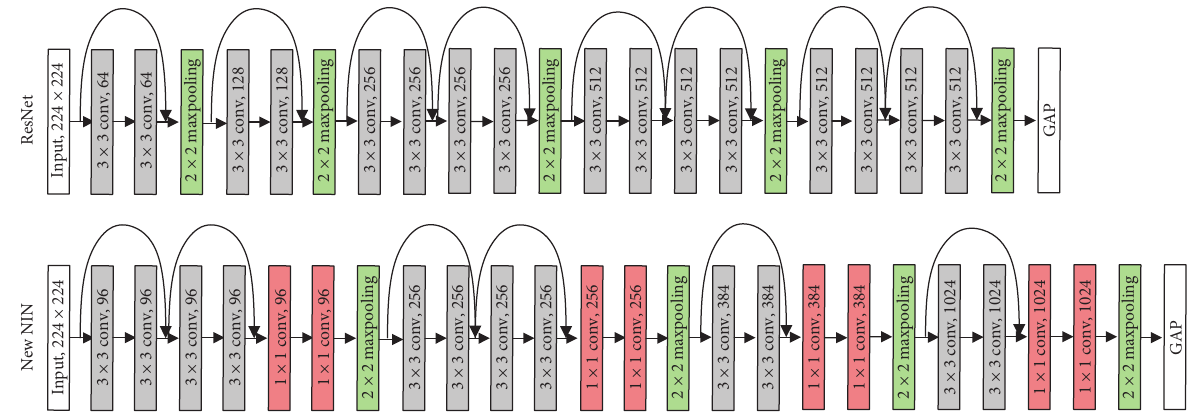
Figure 6: ResNet network structure and optimized NIN structure.